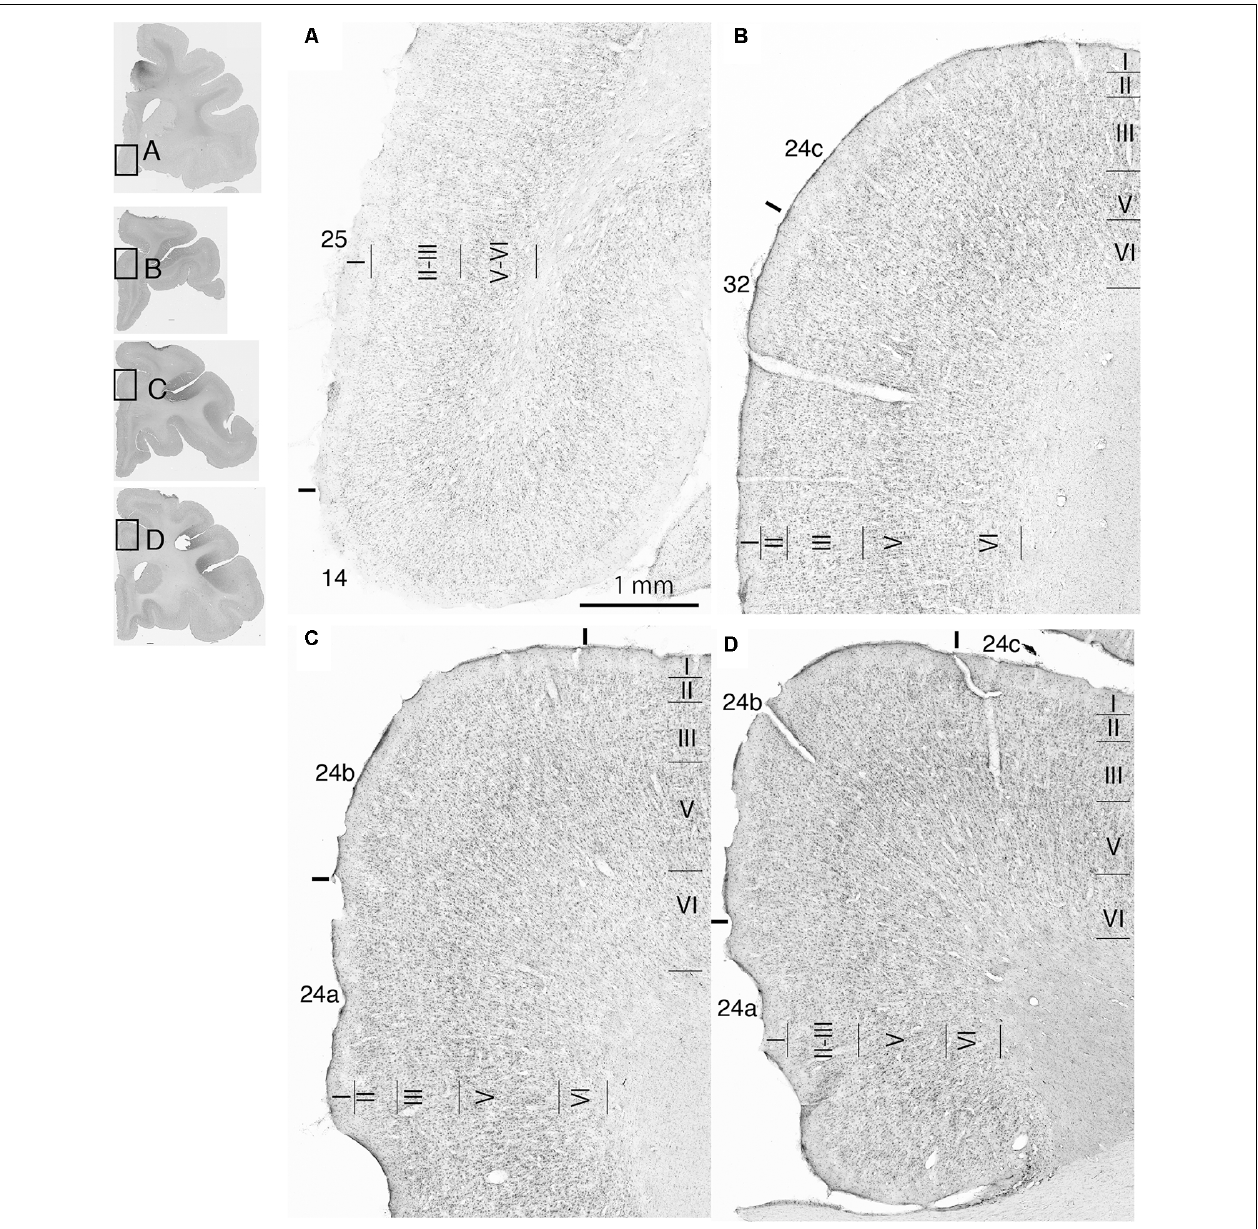
FIGURE 1 | Photomicrographs of the anterior cingulate cortex (ACC) regions. Subgenual ACC (sgACC) corresponds to area 25 (A) . Pregenual ACC (pgACC) includes area 32 (B) and the pregenual portion of area 24 (C) . Dorsal ACC (dACC) is the supragenual portion of area 24 above sgACC (D) .